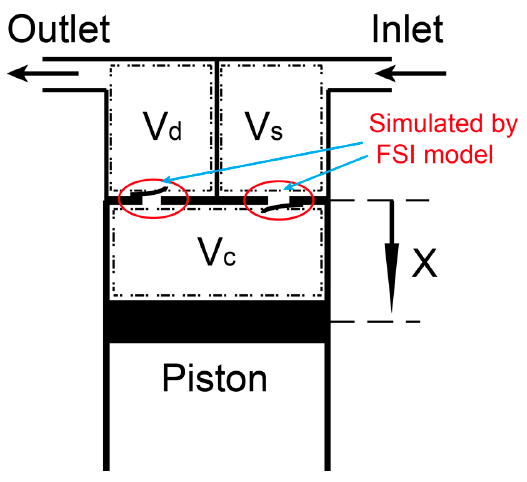
Figure 1. The thermodynamic model of the refrigerator compressor.